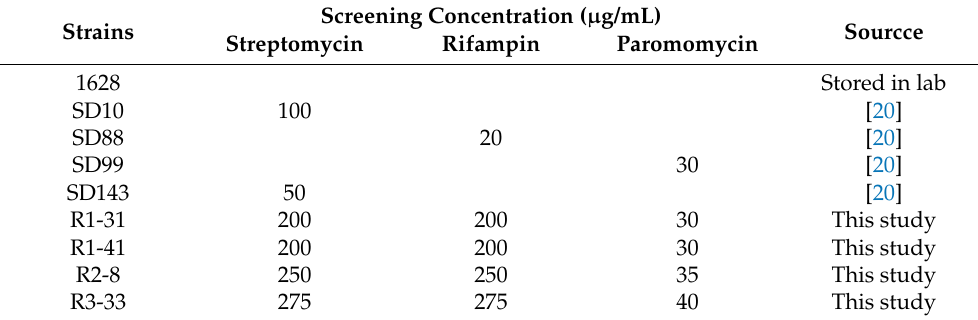
Table 1. The strains used in this